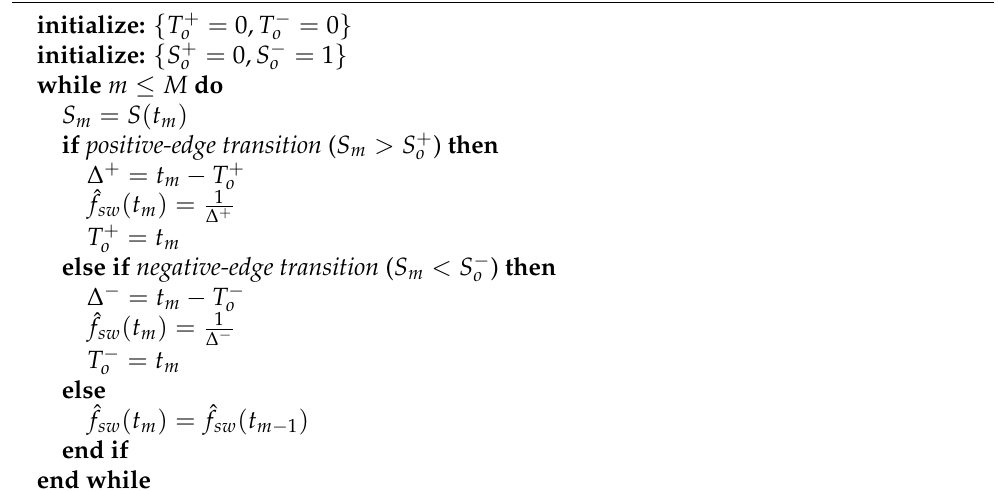
Algorithm 2 extracts, after analyzing all M